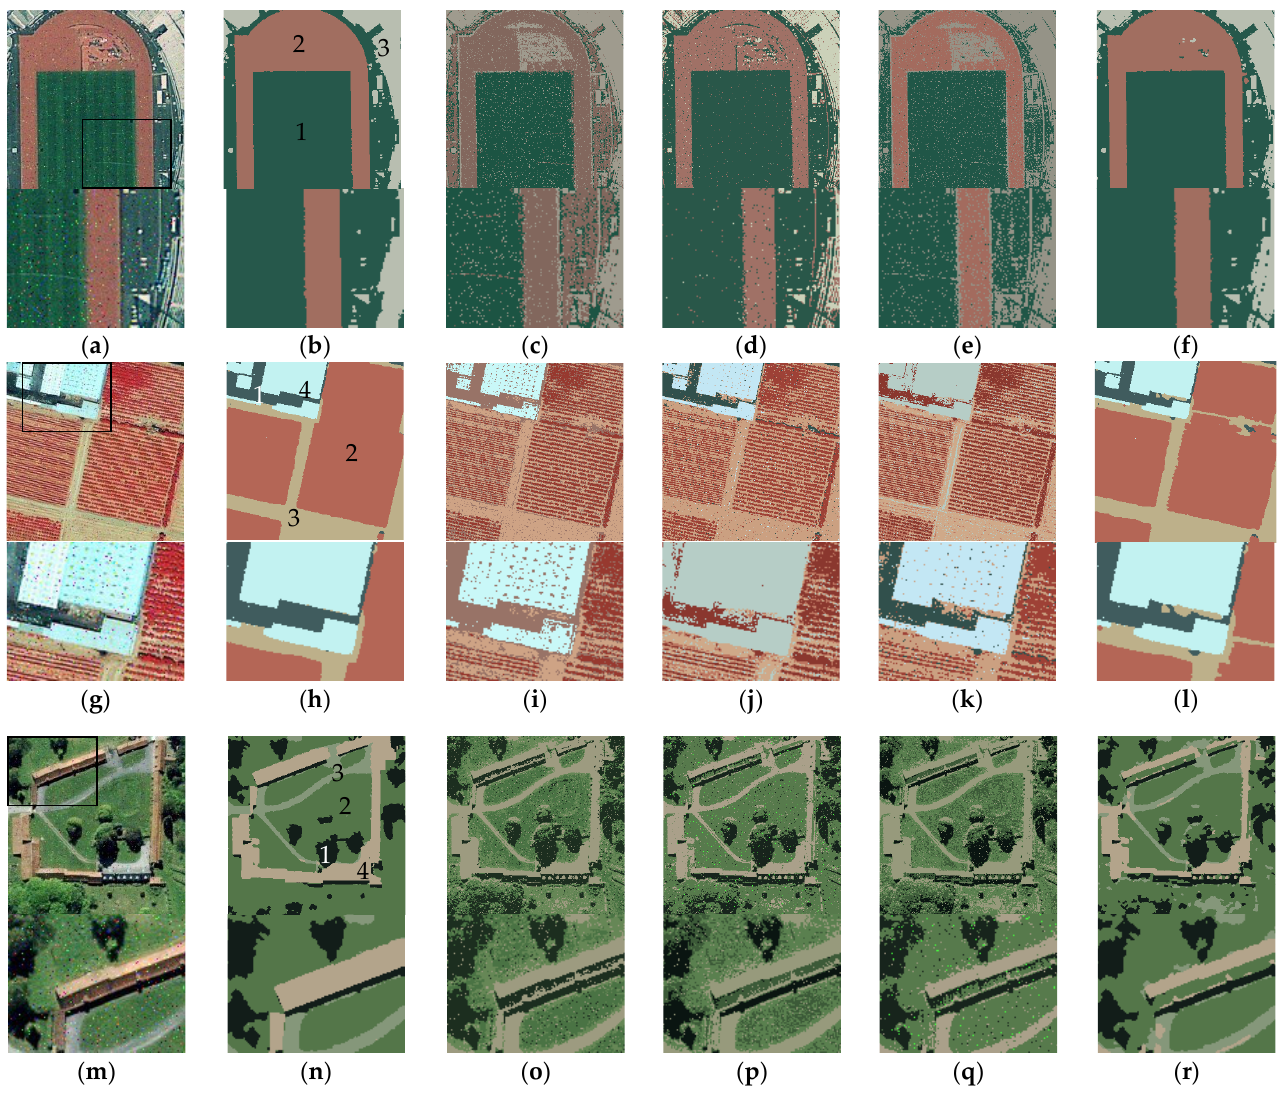
Figure 8. High-resolution multispectral images and their segmentation results. ( a , g , m ) high-resolution multispectral images with noise, and the region in the black square is highlighted, ( b , h , n ) standard segmentation images, and 1 – 4 are the labels of regions, ( c , i , o ) FCM algorithm, ( d , j , p ) GMM algorithm, ( e , k , q ) SMM algorithm, ( f , l , r ) HSMM algorithm.